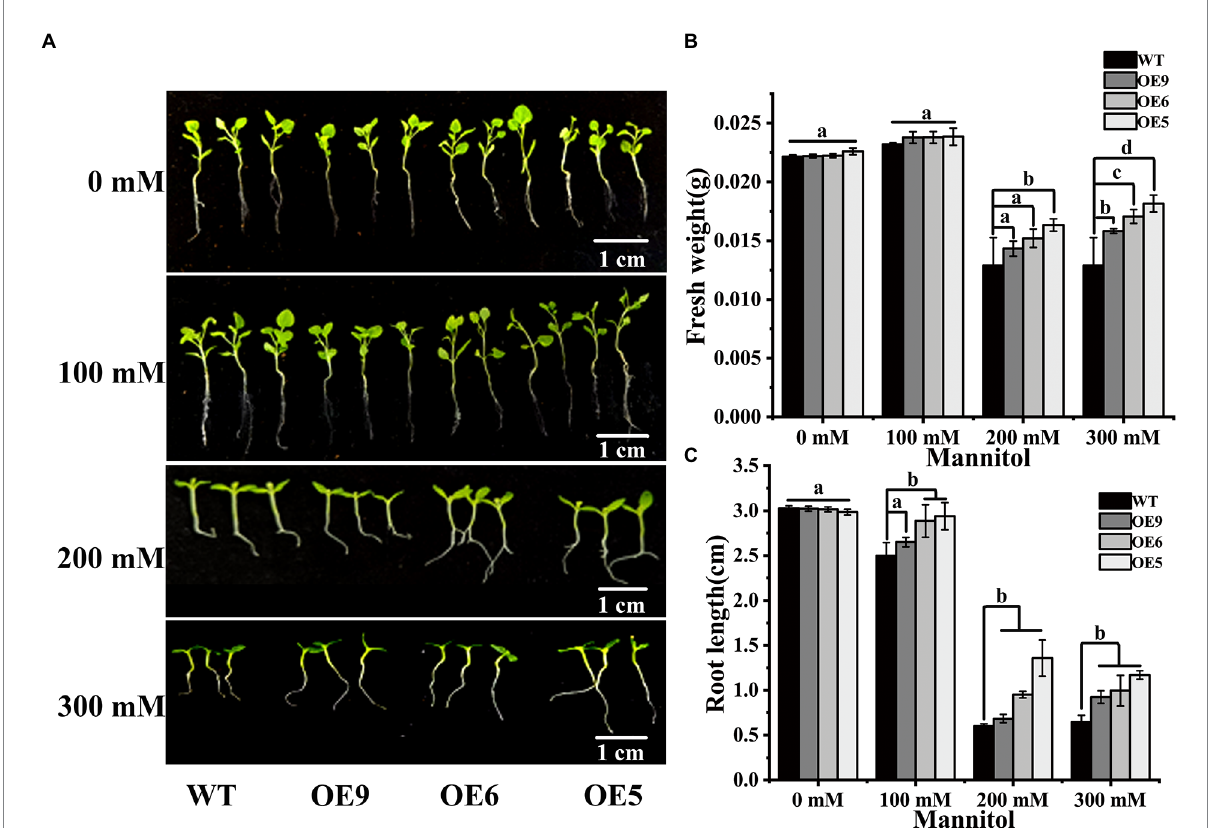
FIGURE 4 WT and OE line tobacco seedlings were treated with different mannitols. (A) Phenotypic comparison after 14d treatment with different mannitol. (B) Fresh weight statistics after treatment in WT and OE lines. (C) Root length statistics after treatment in WT and OE lines. Different letters indicate the significant differences of three replicates as determined by SPSS software ( p <